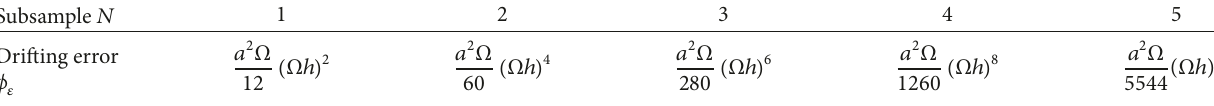
Table 1: Drifting errors for different algorithms of conventional structure.